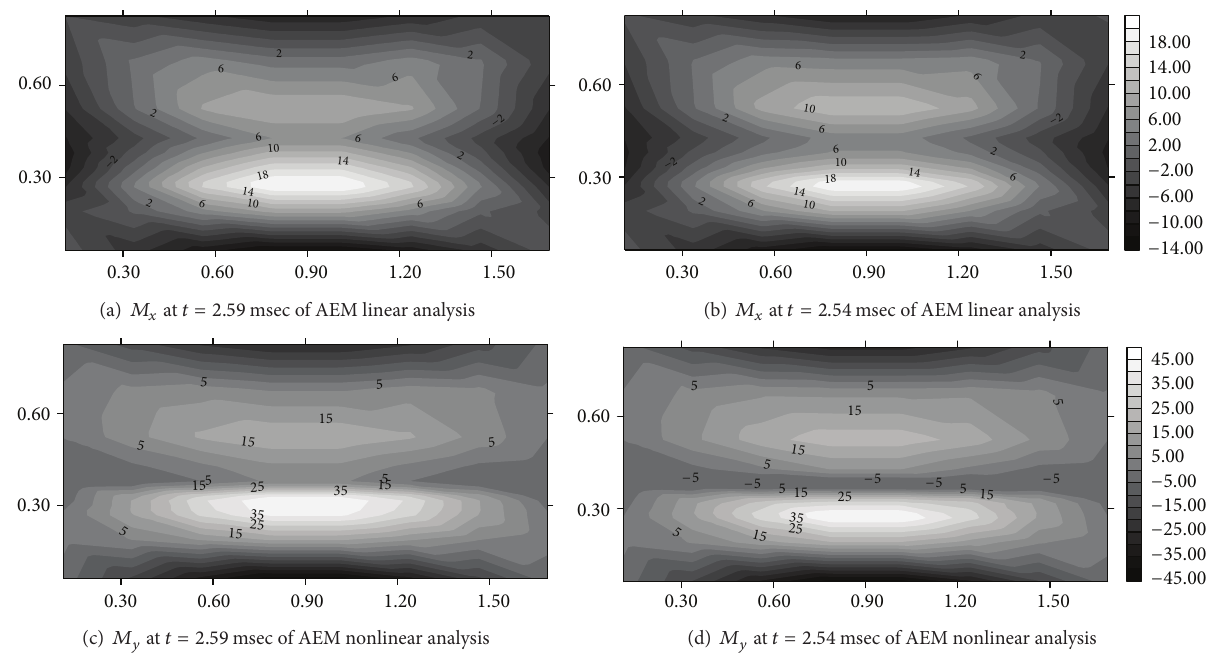
(c) 𝑀 𝑦 at 𝑡 = 2.59 msec of AEM nonlinear analysis (d) 𝑀 𝑦 at 𝑡 = 2.54 msec of AEM nonlinear analysis Figure 16: Contour lines of moments 𝑀 𝑥 and 𝑀 𝑦 (kNm/m) at the time of maximum transverse displacement.